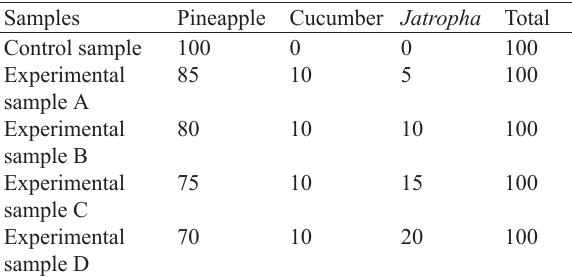
Table 1 Concentrations of cucumber fruit, pineapple, and Jatropha leaf in jam,